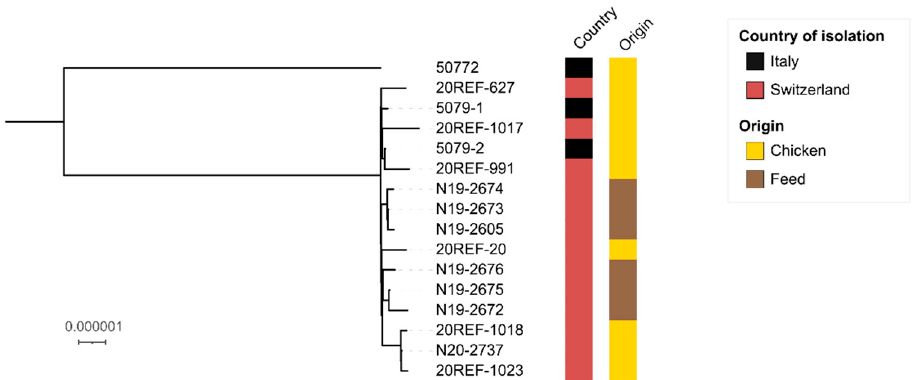
Figure 2. Maximum-likelihood phylogenetic tree of 16 Salmonella Jerusalem isolates. The country and origin of isolation are labelled according to the legend. The scale bar indicates the number of variant sites in a 4.381 Mbp core genome. The tree was visualized using iTOL [30].